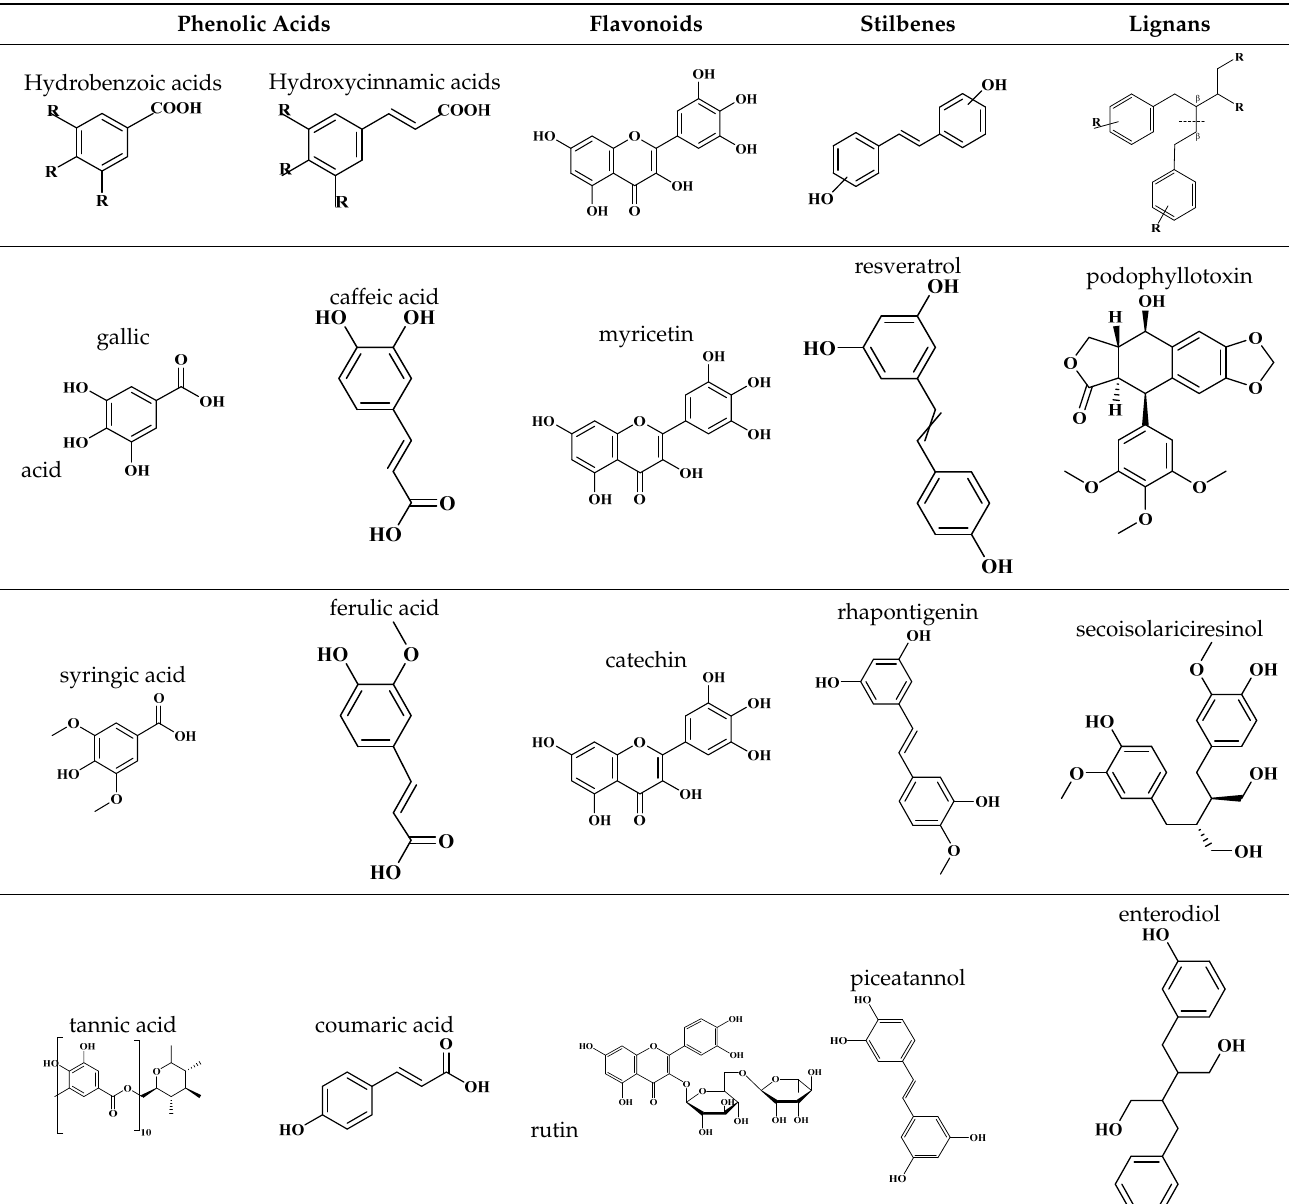
Table 1. Chemical structure of polyphenols and some examples of subgroups of polyphenols.